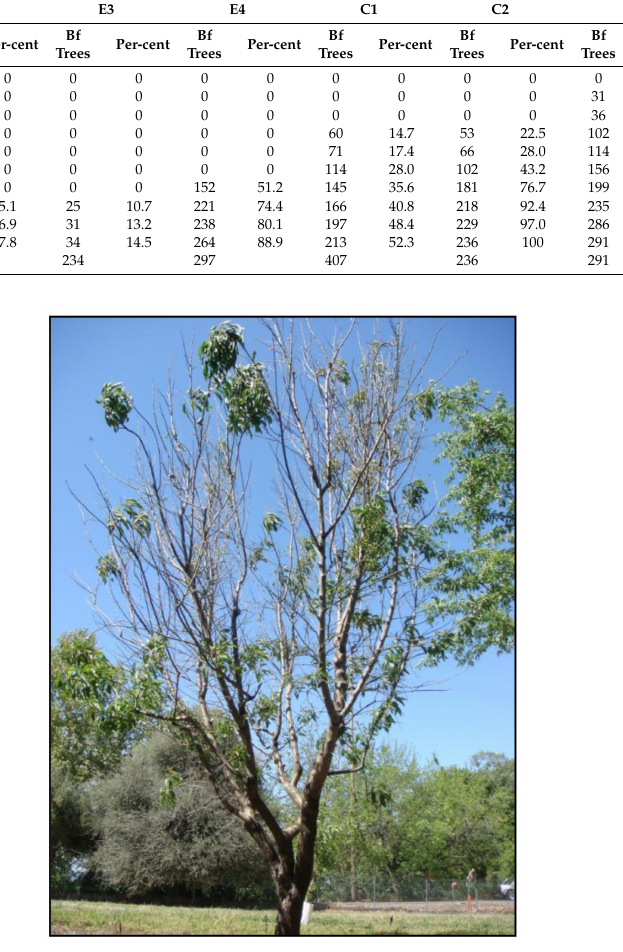
Figure 3. NBF expression in a nine-year-old tree where NBF was first observed in year 5, resulting in abnormal tree growth and loss of commercial